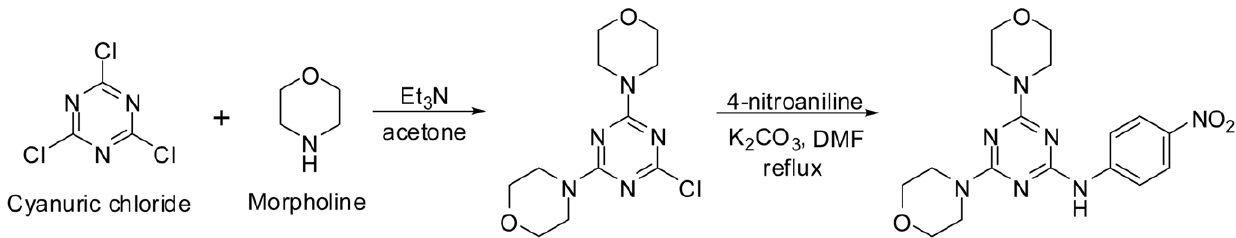
Figure 1. Brief scheme of the synthetic process of MHY1485.